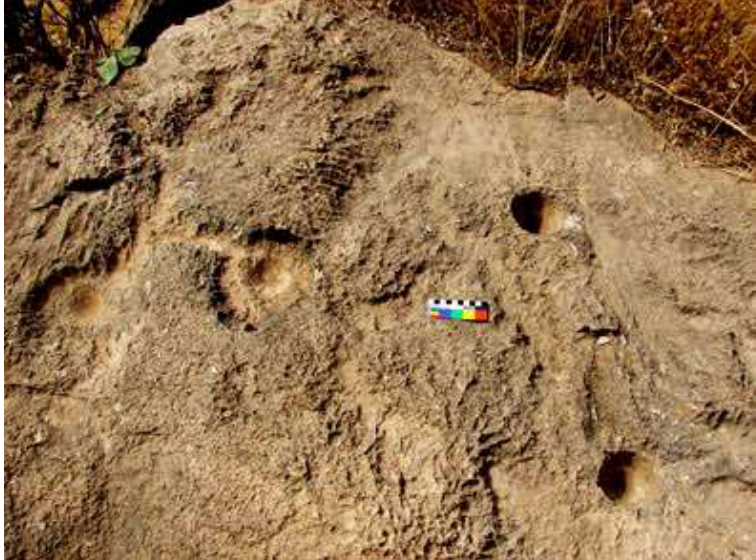
Figure 7. Hawramn, Palangan village, two mortars with 10 cm diameters on the right and two cupules on the left with 4 cm diameter and cup and ring marks, which are connected with a